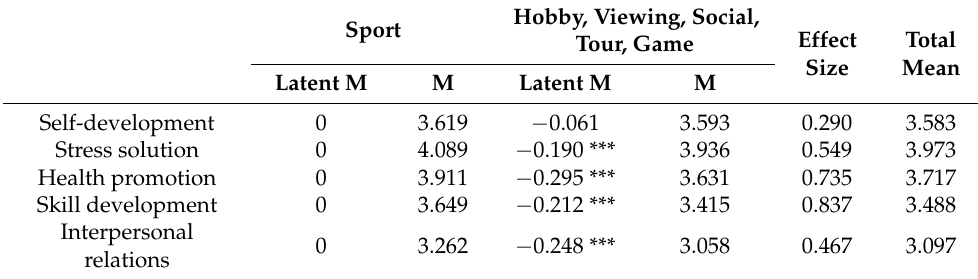
Table 5. Latent means for leisure satisfaction by leisure